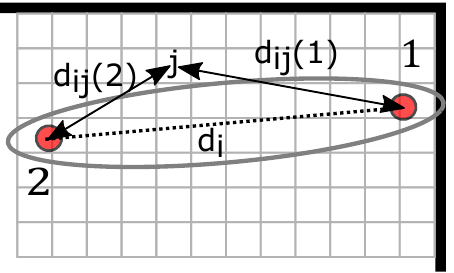
Figure 4. Weight function of